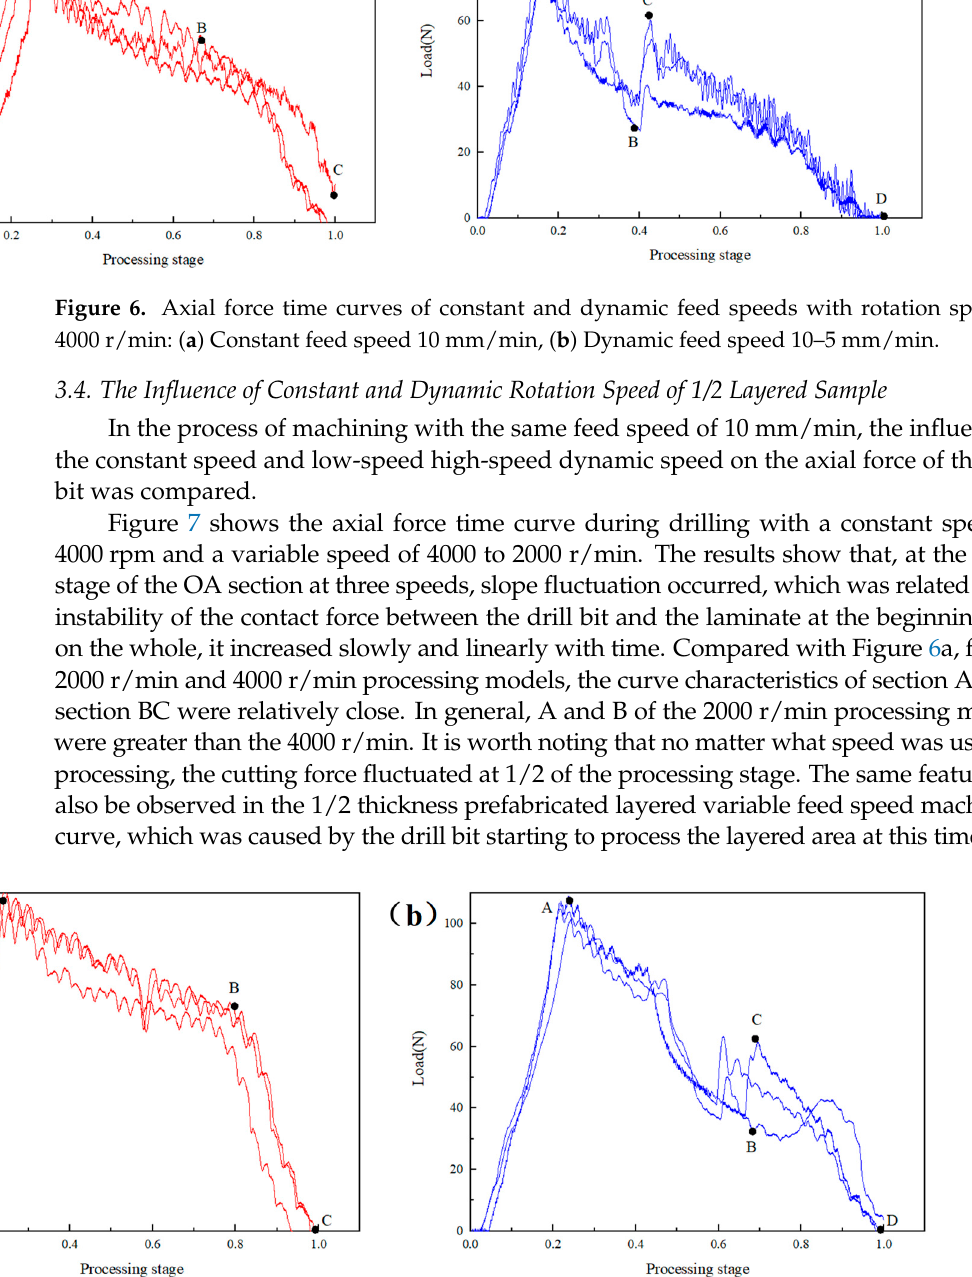
Figure 7. Axial force time curve of composites at constant and dynamic rotations speed: ( a ) Constant speed 2000 r/min, ( b ) Dynamic speed 2000 – 4000 r/min.